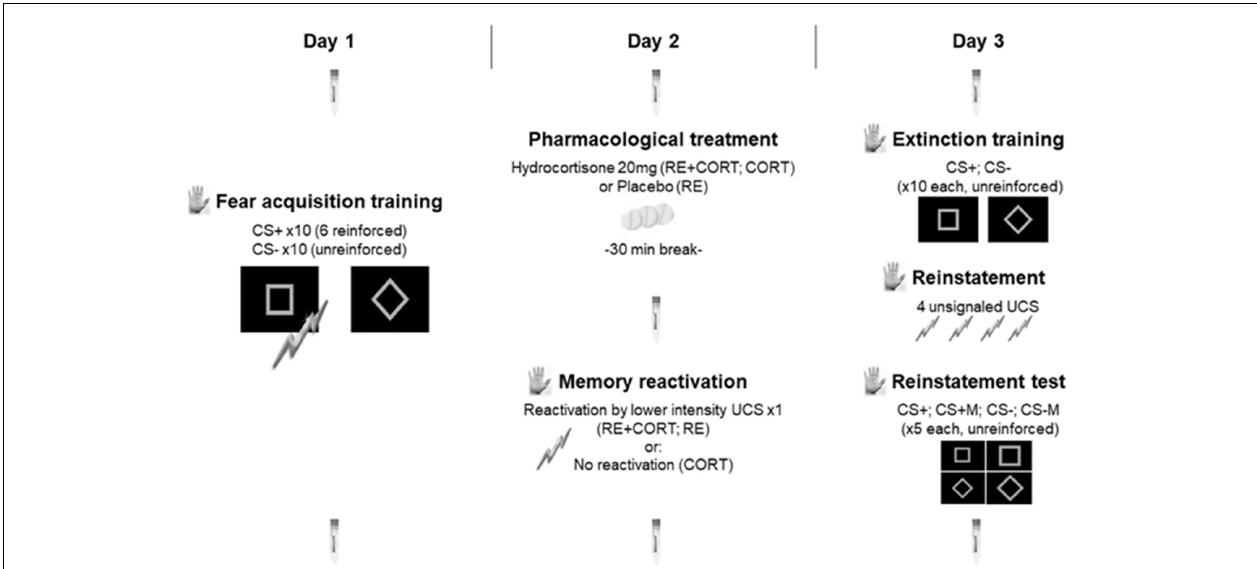
FIGURE 1 | Experimental timeline. The testing was conducted on three consecutive days separated by 24-h intervals: fear acquisition training on day 1; pharmacological treatment and memory reactivation on day 2; extinction training, reinstatement and reinstatement test on day 3. The procedure was identical for the three groups on days 1 and 3 and differed between the three groups only on day 2, in which memory was either reactivated (RE+CORT, RE groups) or not reactivated (CORT group) following the administration of cortisol (RE+CORT, CORT) or placebo (RE). Skin conductance responses (SCR; illustrated by the palm) served as a measure of conditioned fear, and were recorded during all experimental phases. Seven saliva samples (illustrated by the saliva collecting devices) were used to assess salivary cortisol, and were collected during the three experimental days. CS, conditioned stimulus; CSM, conditioned stimulus modified. Bolts, representation of the unconditioned stimulus